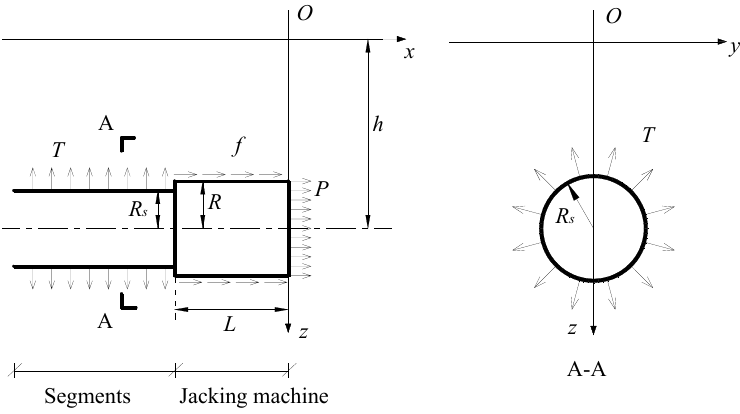
Figure 3. Calculation schematic of Mindlin’s solution.